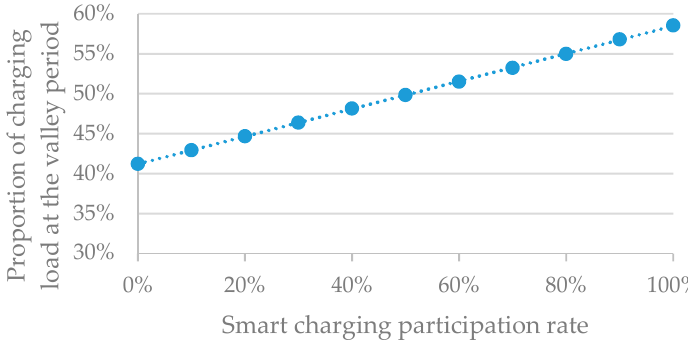
Figure 10. Sensitivity of charging load at the valley period to promoting smart charging.